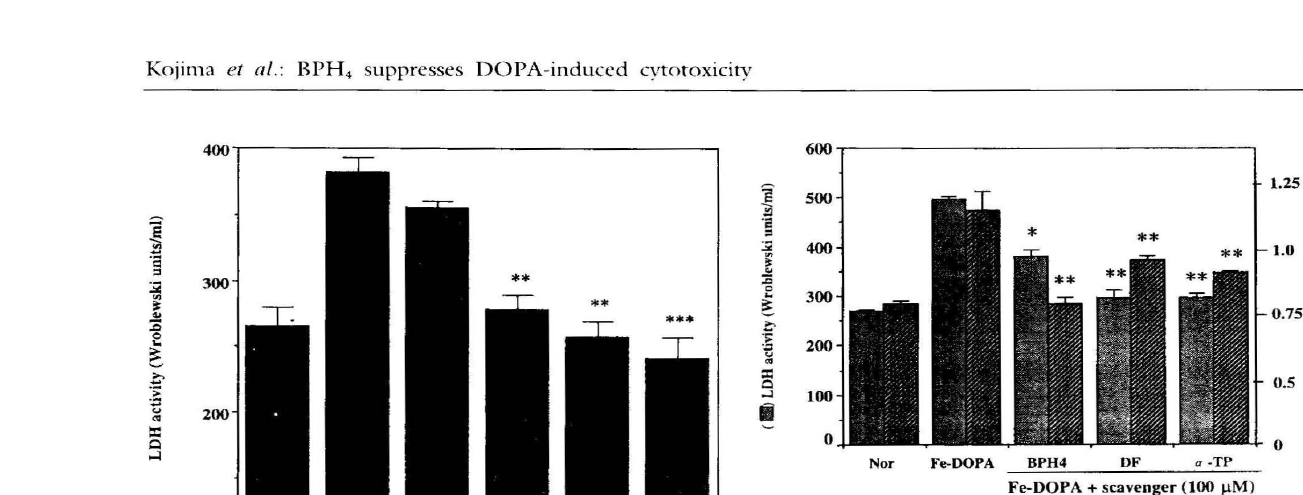
Figure 5. Effect of BPH 4 and other scavengers on the elevation of LDH activity and lipid peroxides induced by Fe"'-DOPA complex in cultured PC-12 cells. A fixed concentration (100 IJ.M ) of BPH. or another scavenger was added to the medium simultaneously with 50